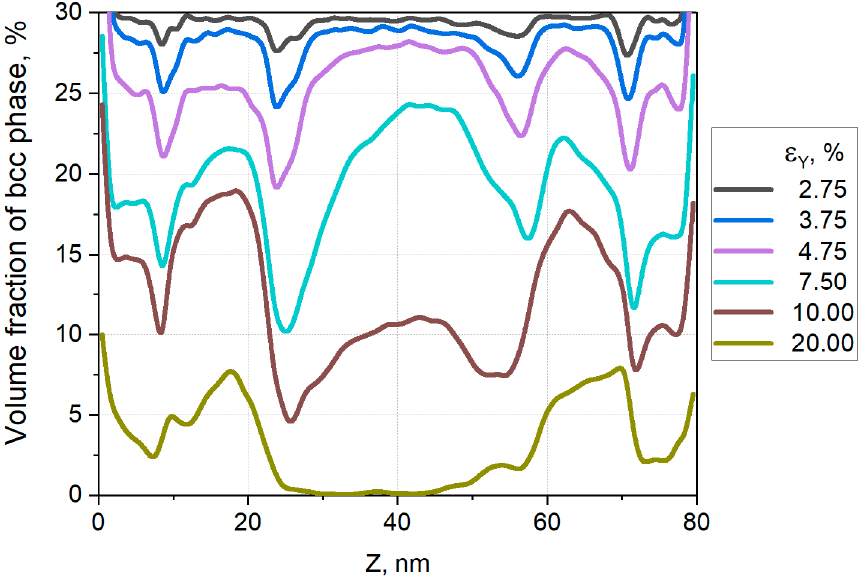
Figure 12. Z-axial distribution of the volume fraction of the bcc phase for different compressive strains of the bcc30_L1 sample. strains of the bcc30_L1